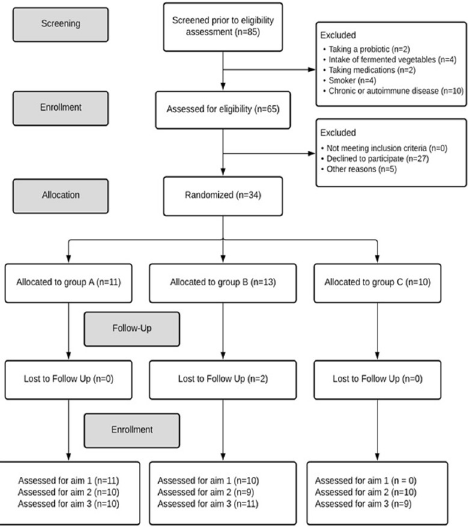
Fig 1. Consort diagram showing the flow of participants in the fermented vegetable